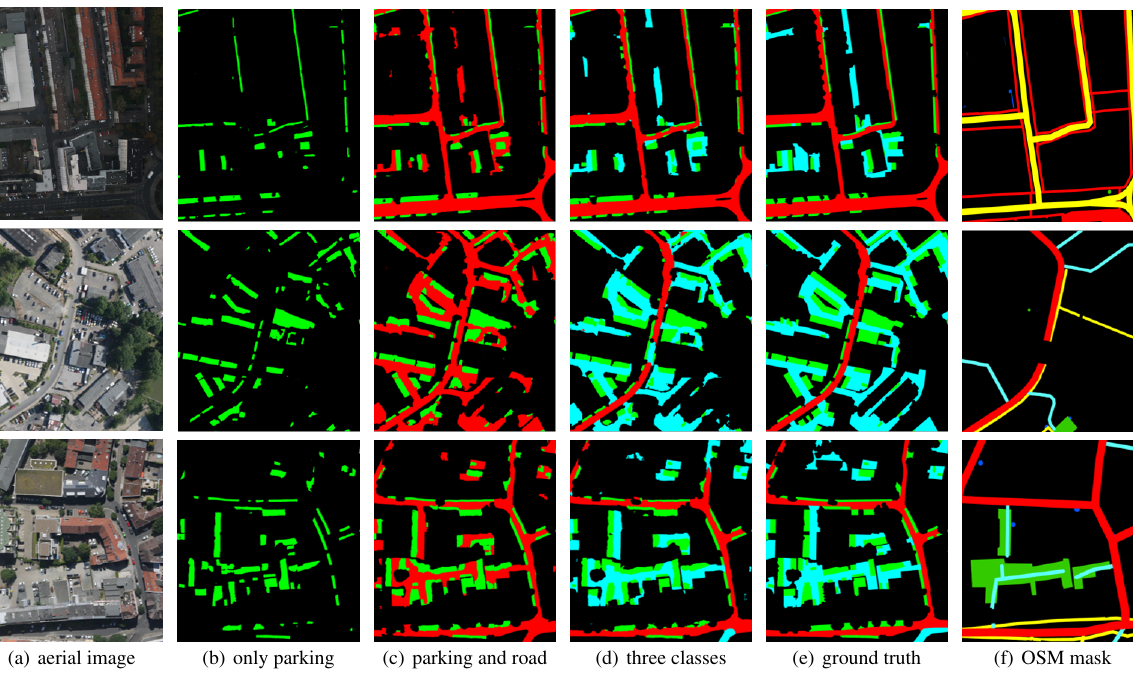
Figure 8. Qualitative comparison of the impact of the number of classes in the training set on the SkipFuse-Dense-U-Net model. Color coding: ∎∎∎∎∎∎∎∎∎∎∎∎∎∎∎∎∎ parking area, ∎∎∎∎∎∎∎∎∎∎∎∎∎∎∎∎∎ road, ∎∎∎∎∎∎∎∎∎∎∎∎∎∎∎∎∎ access way, ∎∎∎∎∎∎∎∎∎∎∎∎∎∎∎∎∎ pedestrian/bike way and ∎∎∎∎∎∎∎∎∎∎∎∎∎∎∎∎∎ bicycle